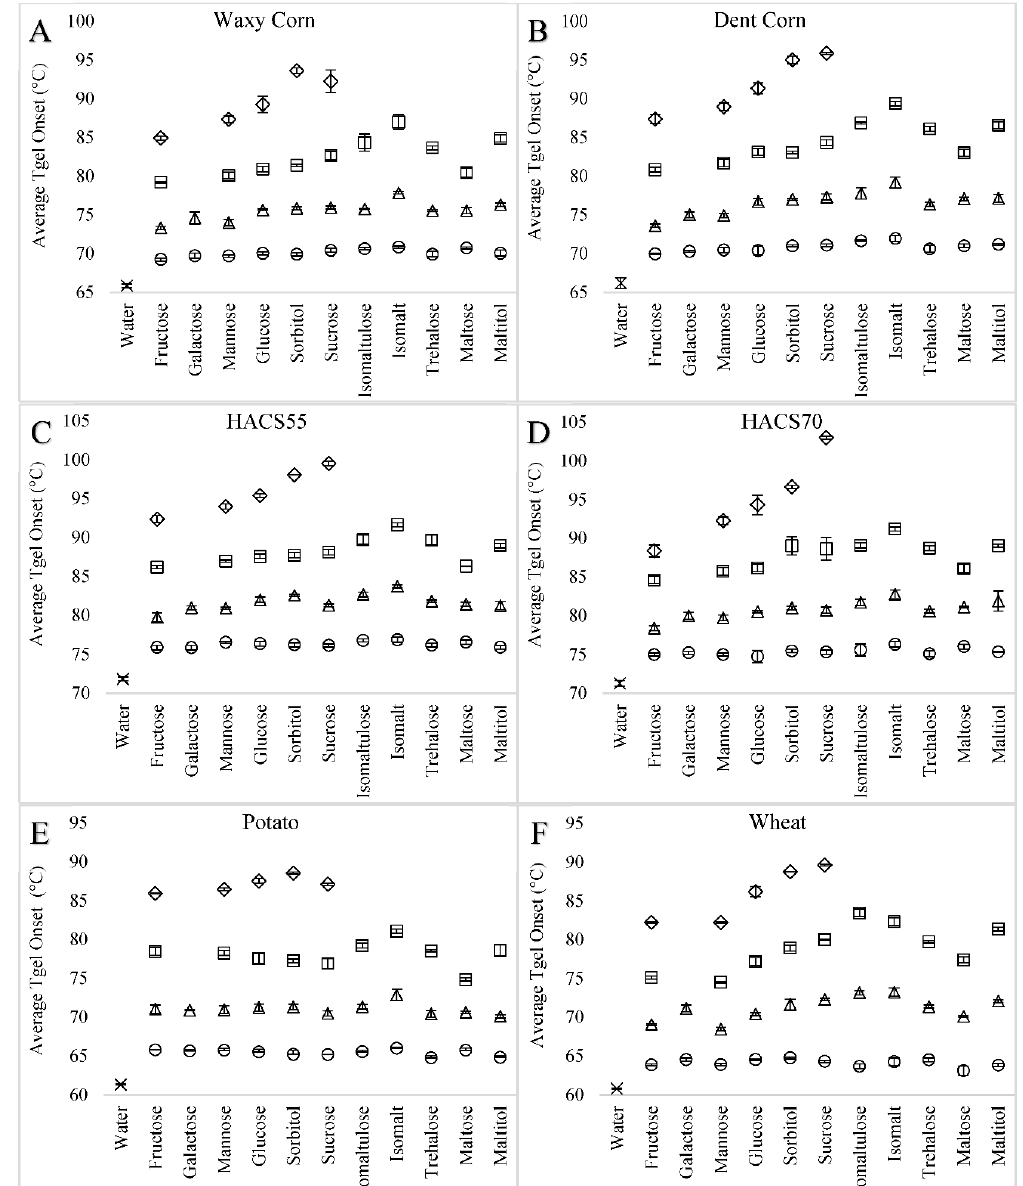
Figure 1. E ff ects of sweetener type and concentration in solution on the onset T gel s of di ff erent starches: ( A ) waxy corn, ( B ) dent corn, ( C ) HACS55, ( D ) HACS70, ( E ) potato, and ( F ) wheat starch. Sweetener solutions are grouped by similar solids content: 1 M mono-, 0.5 M disaccharide solutions ( mono-, 1 M disaccharide solutions ( ∆ ); 3 M mono- and 1.5 M disaccharide solutions ( (cid:3) ); 4 M mono-